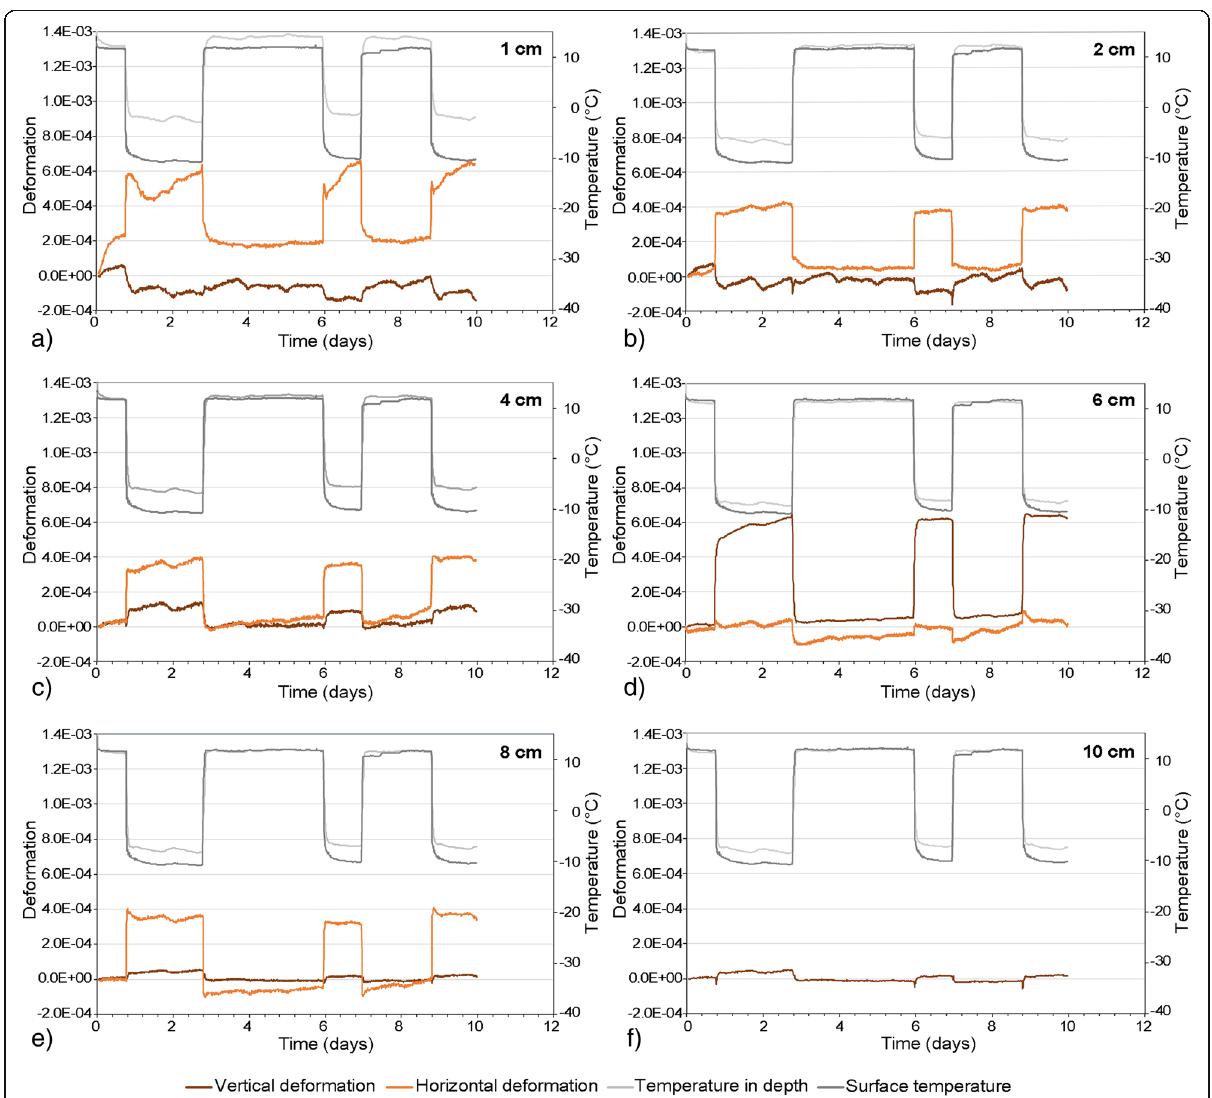
Fig. 7 Main horizontal and vertical dilatation behavior according to freeze-thaw cycles and corresponding temperature of the surface and in depth at the level of the strain gage at a 1 cm, b 2 cm, c 4 cm, d 6 cm, e 8 cm, and f 10